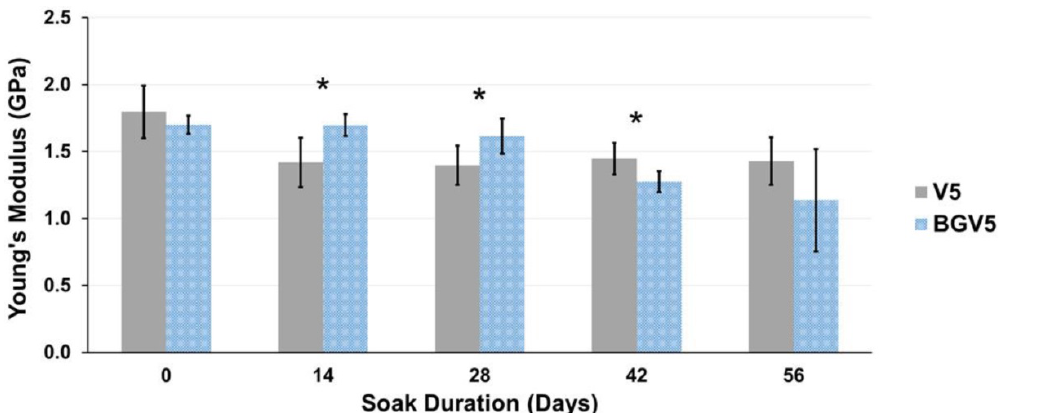
Figure 8. The Young’s moduli of V5 and BGV5 over time. An asterisk (*) above a time point represents a significant difference (p<0.05) between the groups (n=5) at that time duration. Error bars represent ± one standard